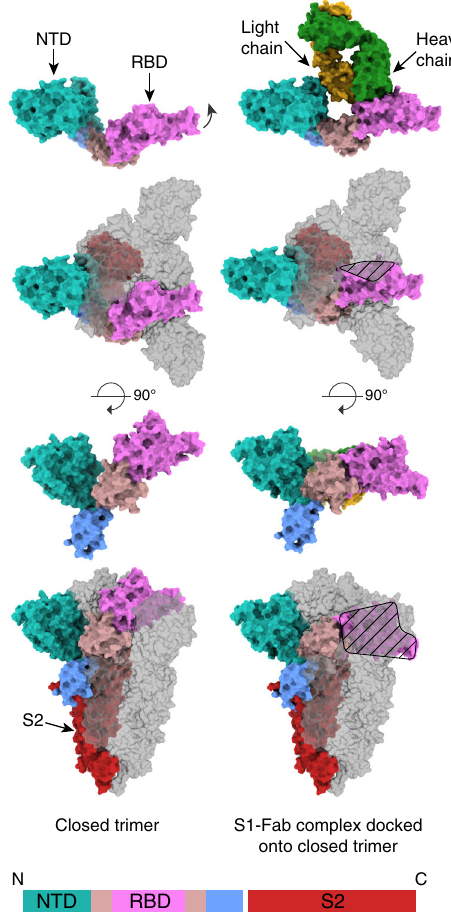
Fig. 1 Structure of CR3022 Fab bound to S in space- fi lling representation. Column on the left shows the native S, while that on the right shows S with bound CR3022. The top row shows a monomer of S1 without and with CR3022. The individual subunits are labelled and coloured according to the bar diagram at the bottom of the fi gure. The second row shows a full S1/S2 trimer in the same orientation as the top panel with one monomer coloured according to the top panel but the other S1 subunits are in grey. Where part of a coloured subunit is eclipsed by a grey subunit the surface is mottled; where there is a steric clash the surface of the coloured subunit is hatched. The third and fourth rows are orthogonal views to the top two rows with the trimer threefold axis vertical. The S2 chain associated with the coloured S1 chain is shown in